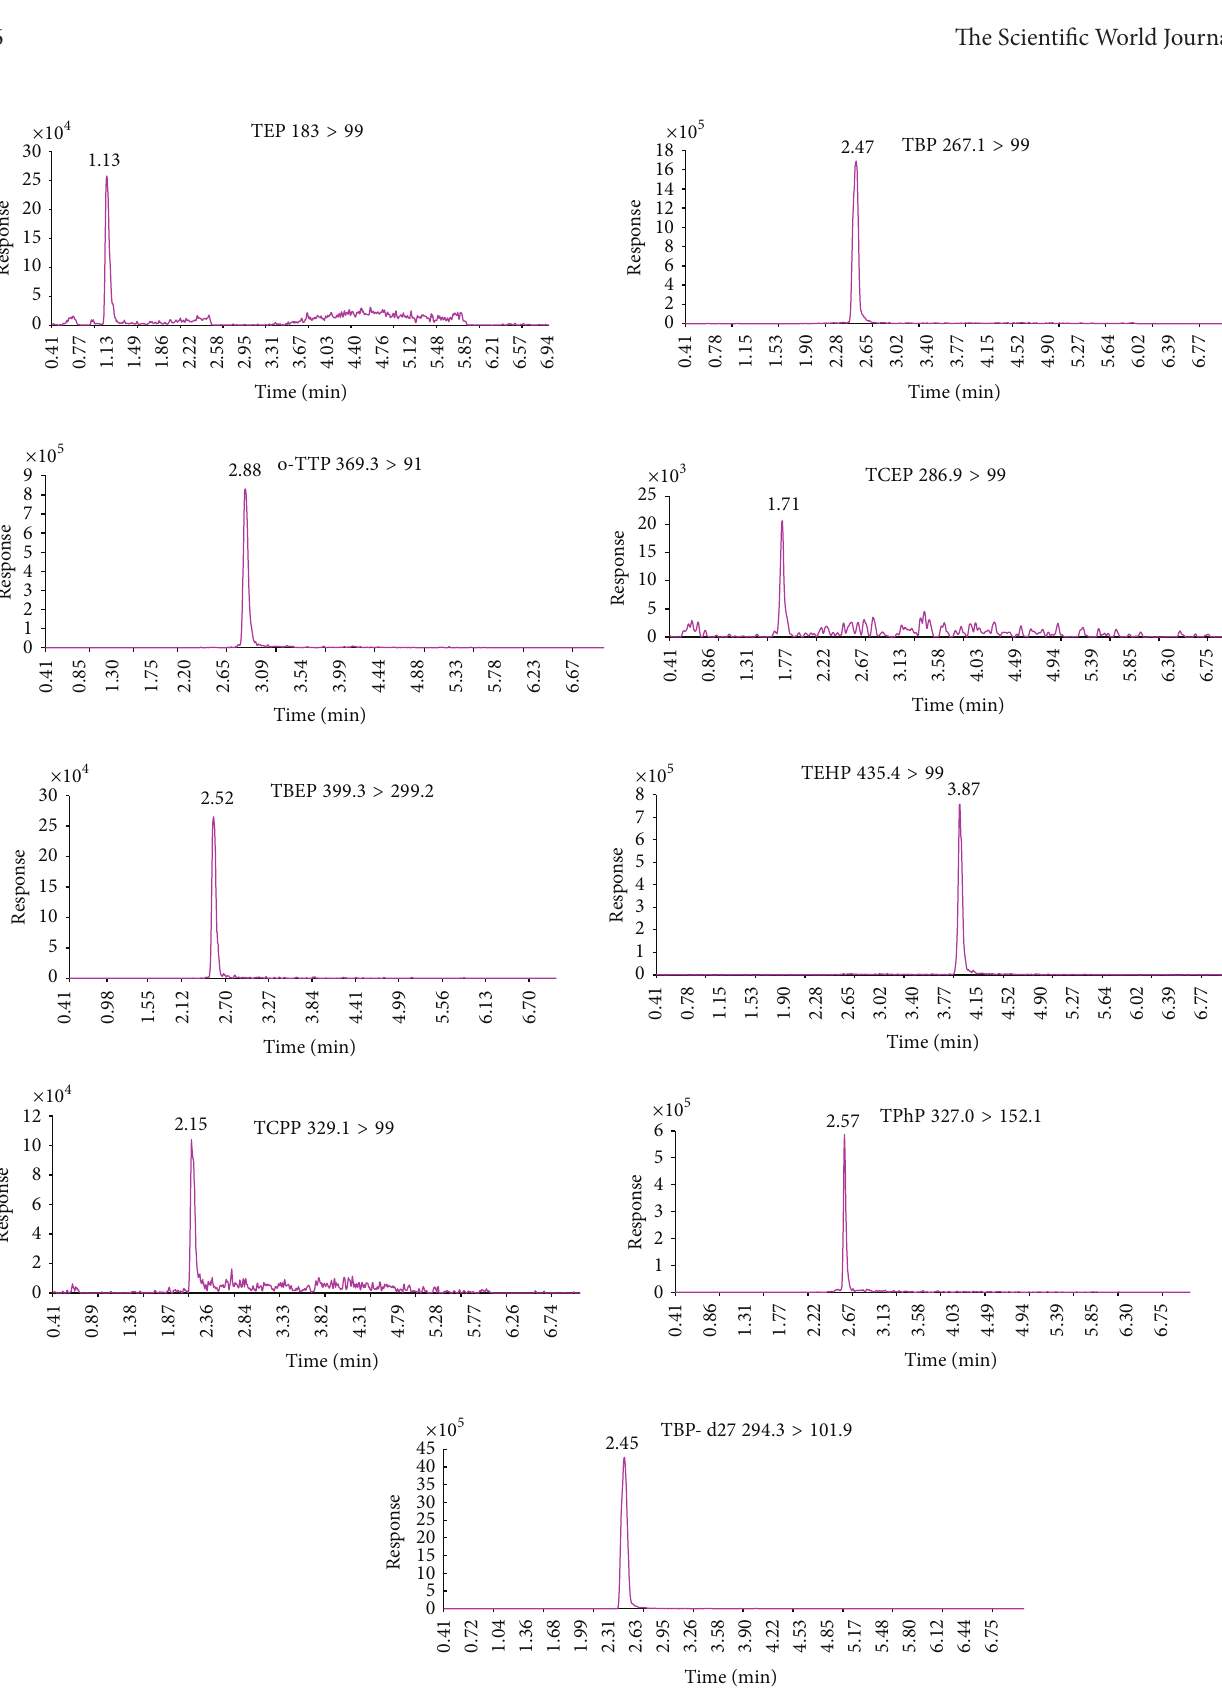
Figure 8: Selected ion chromatograms of the mixed standard solution of OPEs (5.0 𝜇 g/L) and internal standard TBP-d27 (20.0 𝜇